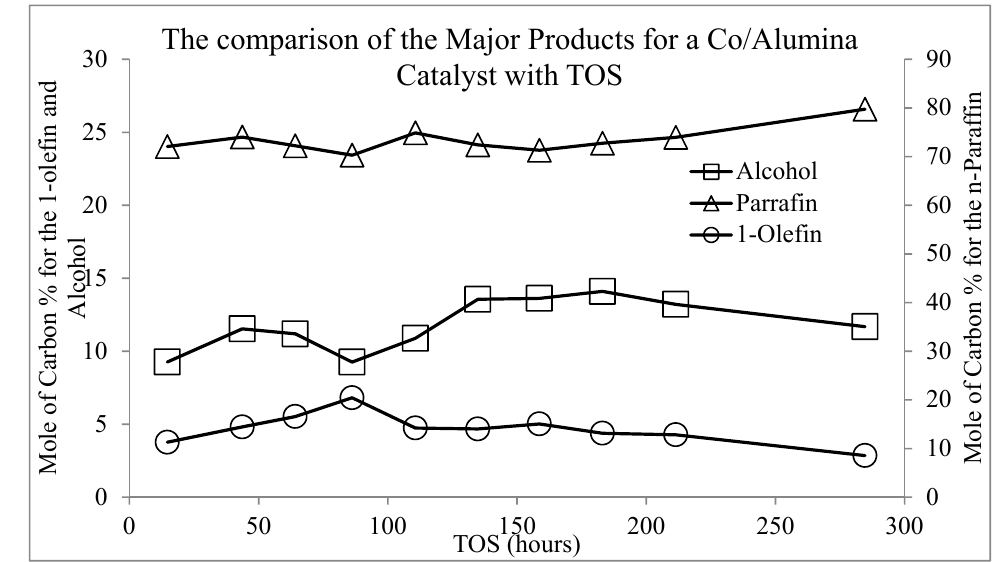
Figure 52. This figure tracks the changes of the major products with time on stream. Reactor conditions: 220 °C, 19.3 bar, WHSV = 5, H 2 /CO = 2.